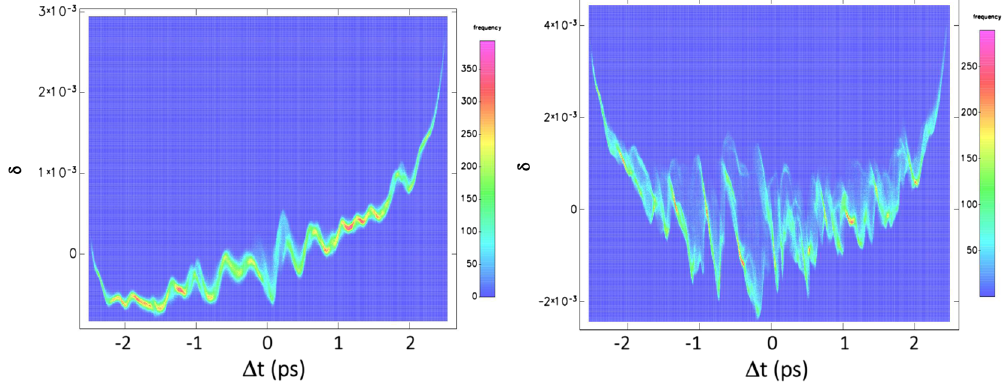
FIG. 8. Electron beam longitudinal phase space after a half turn (left) and after one turn in RIBS.